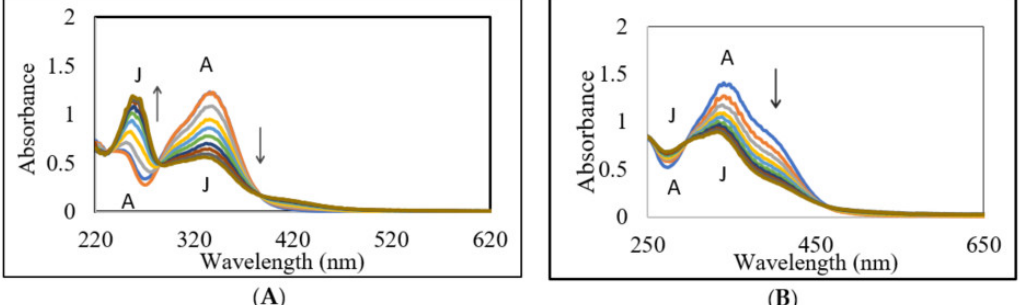
Figure 2. Ultraviolet and visible spectral changes associated with the tyrosinase catalyzed oxidation of DBL catechol. A reaction mixture (1 mL) containing 25 µ g of mushroom tyrosinase and DBL catechol in 50 mM sodium phosphate buffer, pH 6.0 ( A ) or pH 8.0 ( B ) was incubated at room temperature and the absorbance changes occurring at UV and visible regions were followed using a spectrophotometer. For pH 6.0, the reaction was monitored at one min intervals ( A ) Scan A, start of the reaction; Scan J – 9 min reaction). For pH 8.0, the reaction was monitored at two min intervals ( B ) Scan A, start of the reaction; Scan J, 18 min reaction).